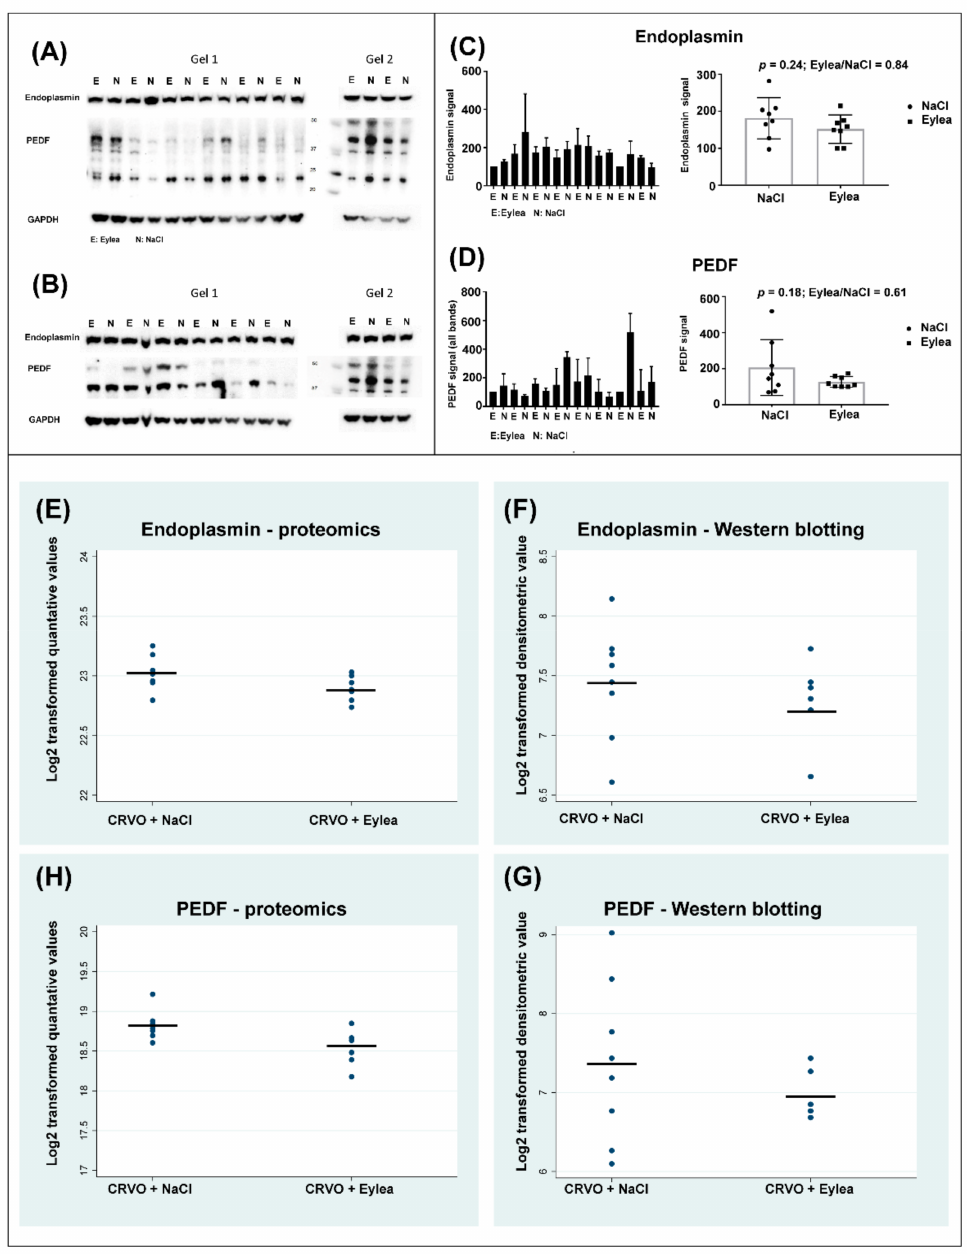
Figure 6. Western blots comparing CRVO + Eylea vs. CRVO + NaCl. ( A – B ) Western blotting was performed in two replicates. ( C – D ) Averages of quantitative data from the two replicates. The changes observed by mass spectrometry in endoplasmin and PEDF following aflibercept intervention were too slight to be confirmed by Western blotting. ( E – G ) Horizontal lines of the plots denote the means of the quantitative data. Standard deviations were larger in data obtained with Western blotting compared with quantitative data obtained through proteomic analysis. Standard deviations of endoplasmin quantification with mass spectrometry and Western blotting were 0.14 and 0.43, respectively. Standard deviations of PEDF quantification with mass spectrometry and Western blotting were 0.23 and 0.76,